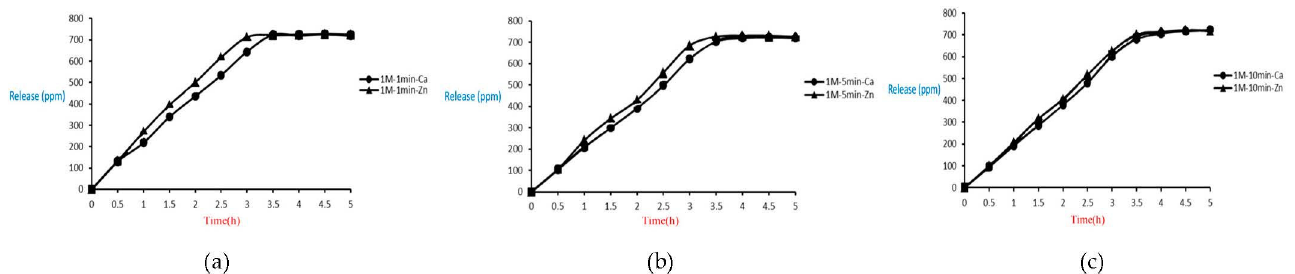
Figure 26. The effect of different cross-linking reagents (1 M, cross-linking time of 1 ( a ), 5 ( b ), 10 ( c ) minute) on releasing of tea tree essential oil from alginate/tea tree essential oil microcapsules in